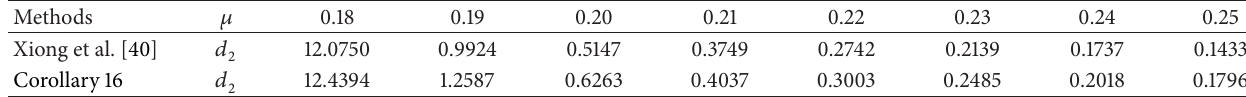
Table 2: Maximum upper bound of 𝑑 2 with Π 2 and different parameter 𝜇 .